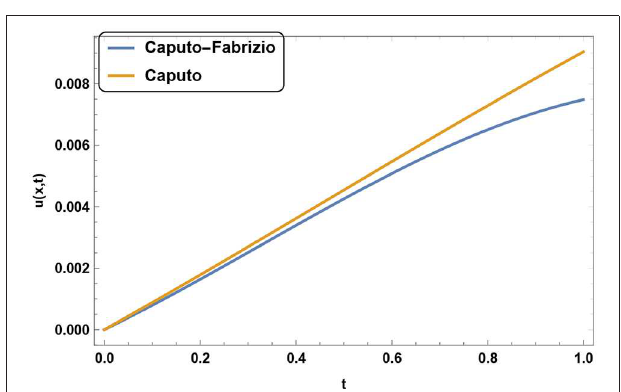
FIGURE 4 | Variation of u for α = 0.9, m = 4, and t = 0.1 in case when time-fractional derivative is of Caputo Fabrizio and Caputo type.